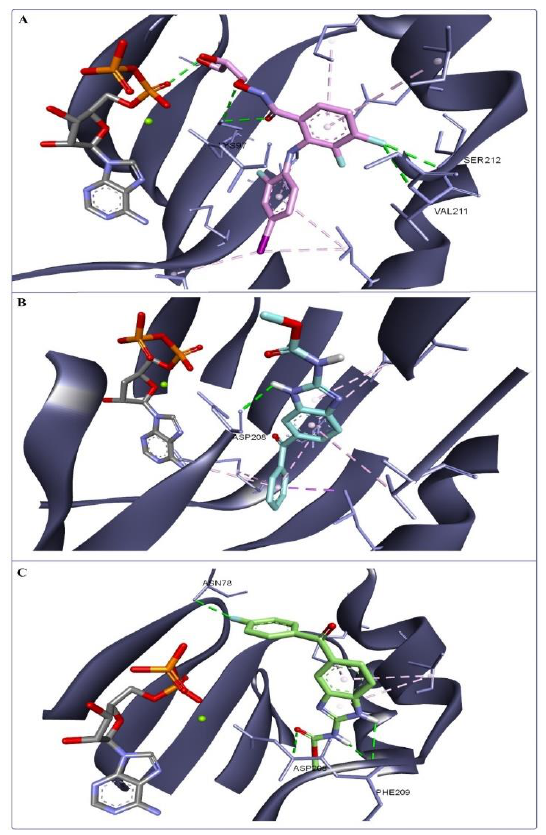
Figure 9. MEK1 (PDB ID: 3EQG) active site complexed with ATP and the native ligand Mirdametinib ( A ), MEB ( B ), and FLU ( C ); HB interactions are depicted as green dotted lines and hydrophobic interactions as purple dotted lines; interacting aminoacids are shown as purple sticks.